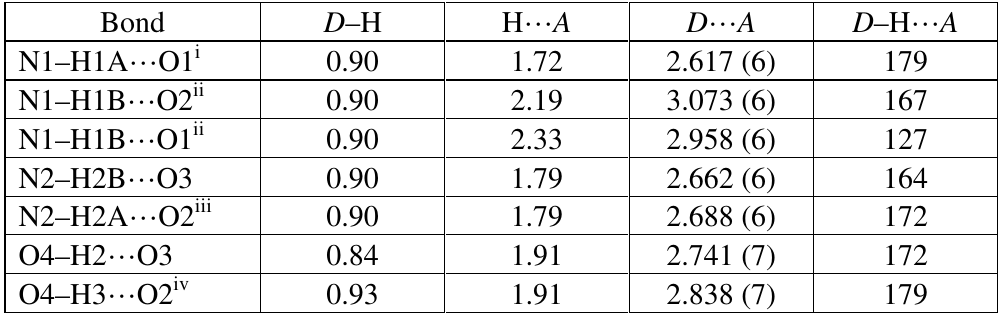
Table 1. Hydrogen-bond geometries for 1 .